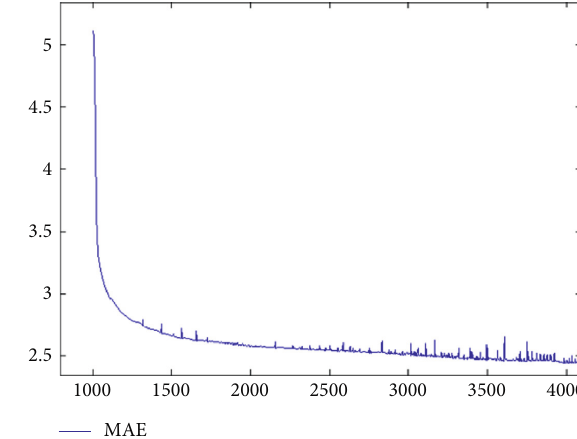
Figure 12: RNN-GCN MAE diagram.